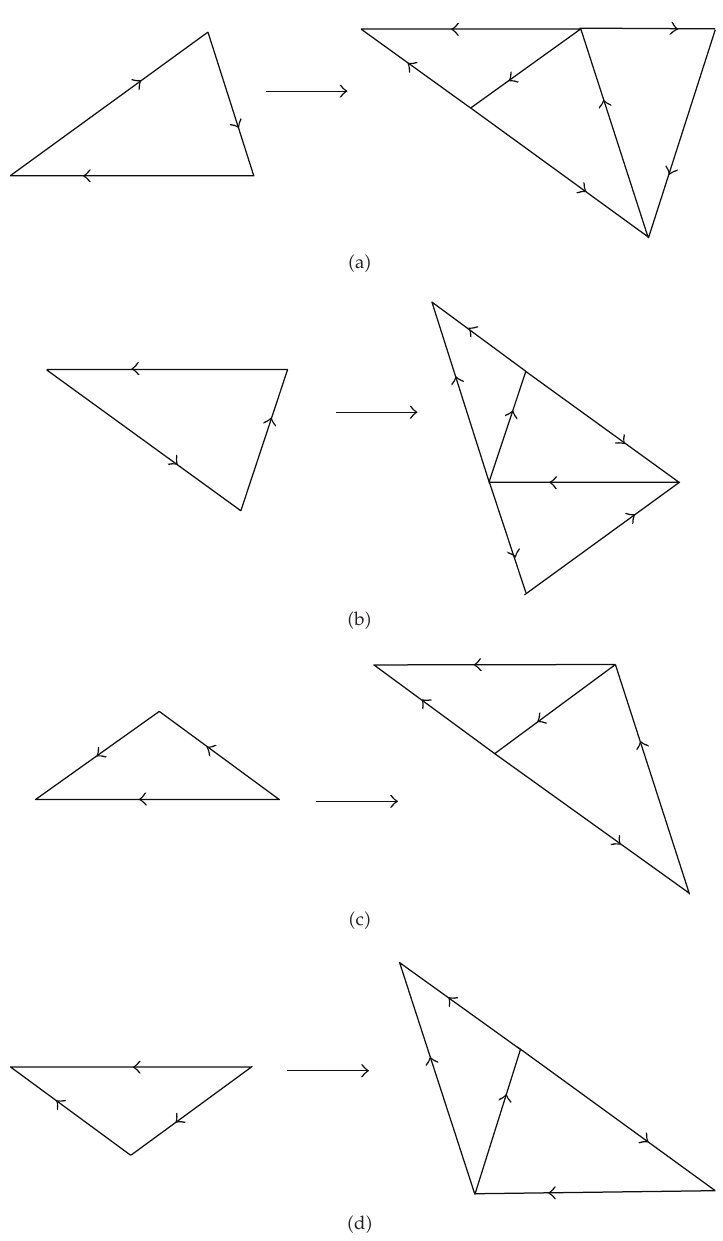
Figure 10: The inflation rules for the tiling space Ω Ξ